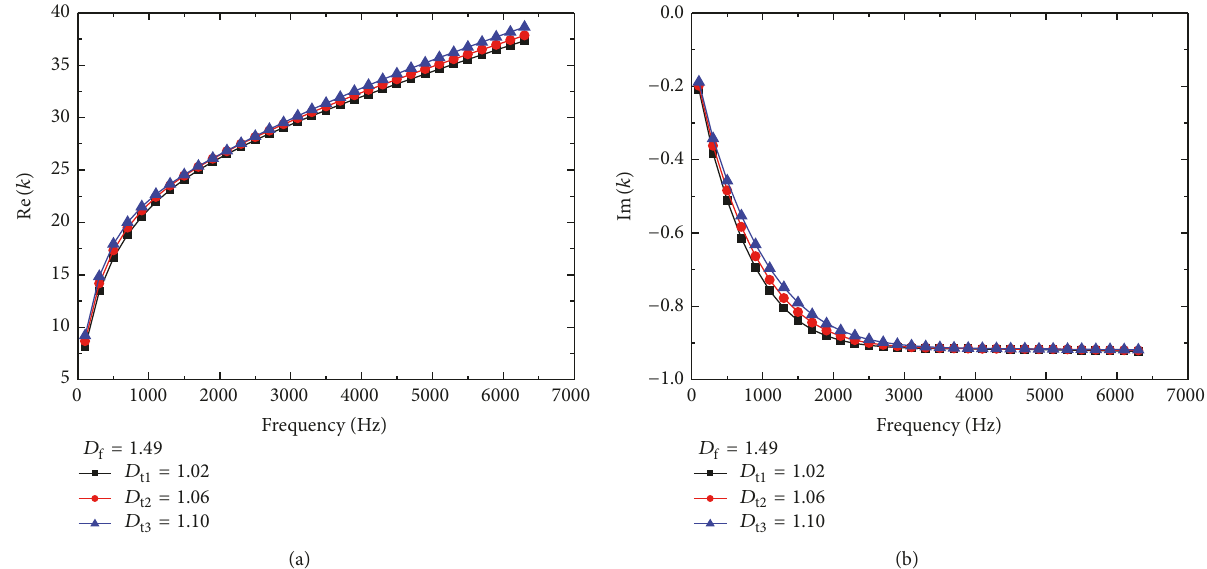
Figure 17: Predictions of the complex wave number 𝑘 with different tortuosity fractal dimensions. (a) The real part of 𝑘 . (b) The imaginary part of 𝑘 .